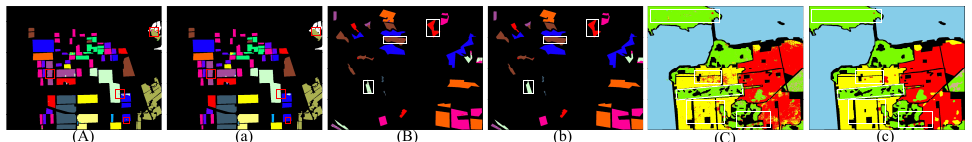
Figure 25. ( A – C ) Classification maps of the proposed HCapsNet without the CRF. ( a – c ) Classification maps of the proposed HCapsNet with the